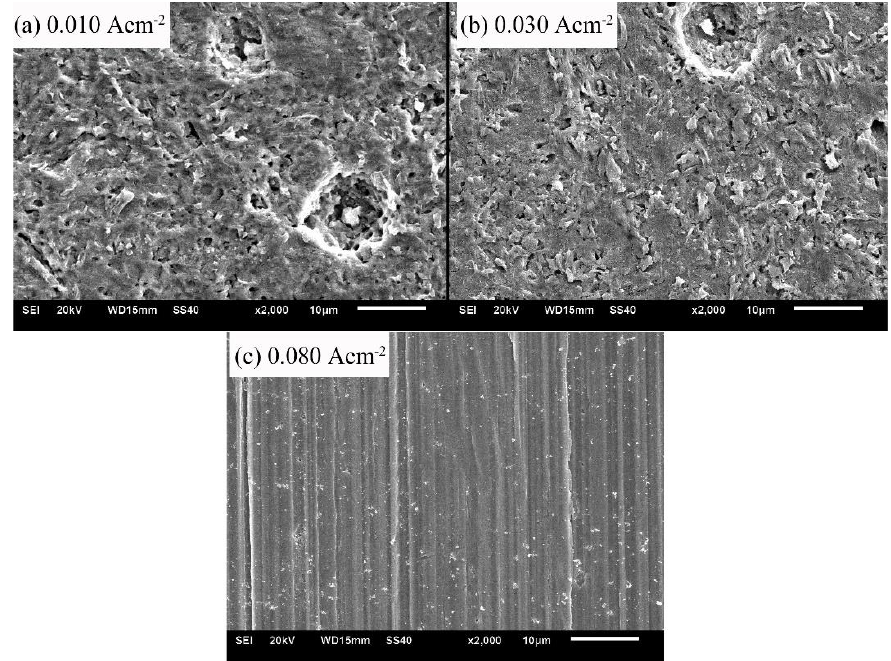
Figure 7. Micro-morphologies of sample surfaces after the galvanostatic polarization test of: 0.010 A·cm −2 ( a ); 0.030 A·cm −2 ( b ); and 0.080 A·cm −2 ( c ).